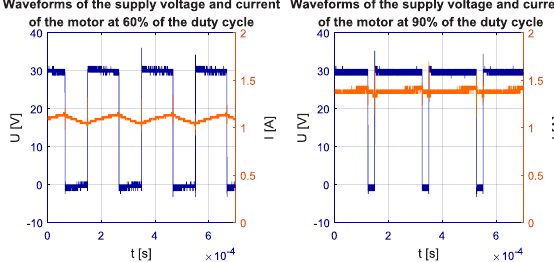
Fig. 4. Supply voltage and current of the magnetoelectric DC motor at duty cycle equal to 60% and 90%